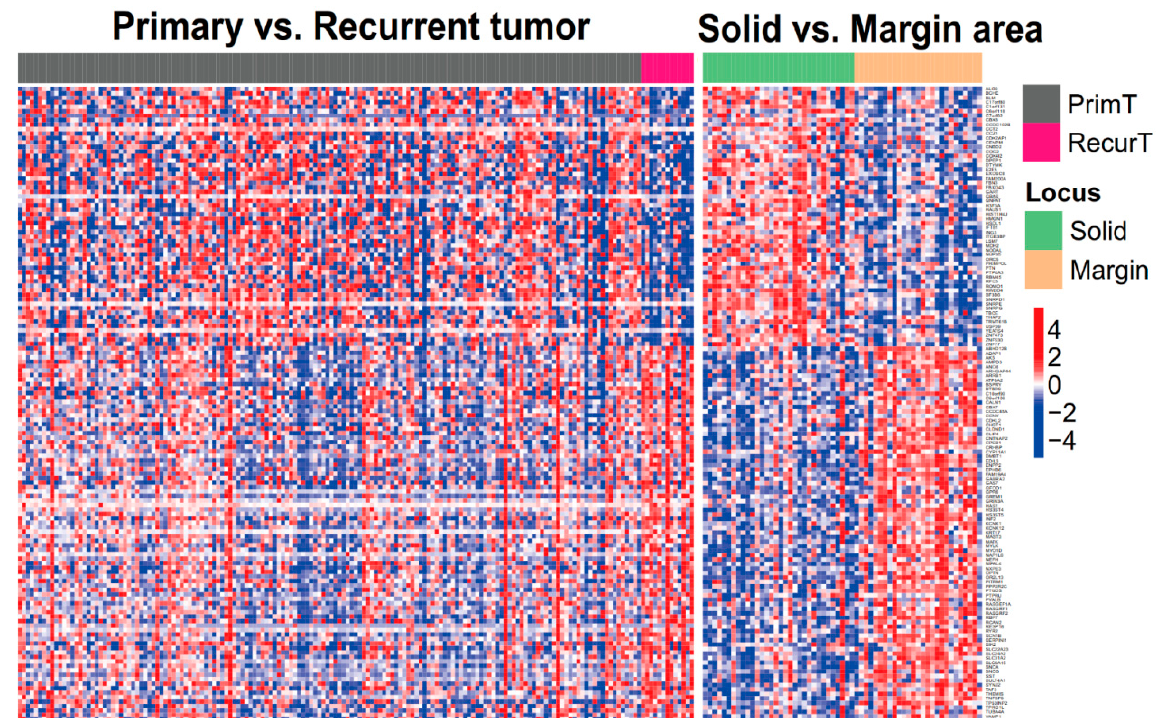
Figure 2. GBM recurrence-associated genes in primary and recurrent tumors. The expression levels of 135 genes relevant to GBM tumor recurrence were similar to the expression levels of genes in the tumor margin of patients with primary GBM. Upregulated genes are in red, and downregulated genes are in blue. Samples and genes are presented on the x and y axes, respectively. Samples from different tumor types and regions are shown using various color bars.